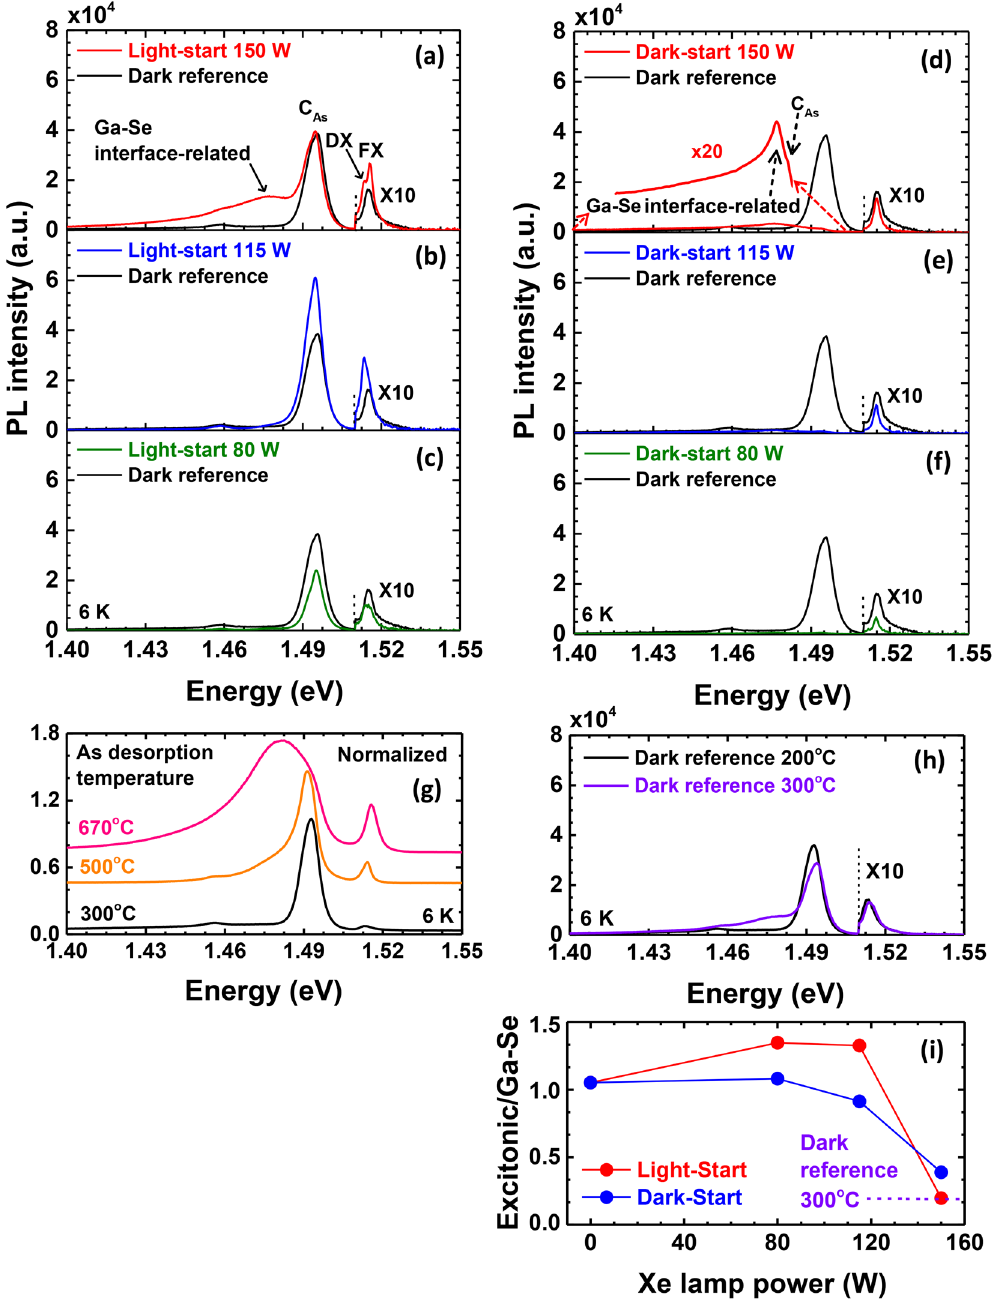
Figure 6. ( a – f ) PL emission from the ZnSe/GaAs interface and the GaAs epilayers of samples grown under light-start and dark-start conditions, respectively. From top to bottom, the Xe lamp power decreases from 150 W to 80 W. All spectra were compared with the dark reference sample. ( g ) Normalized PL spectra of the 200 °C-grown ZnSe samples corresponding to As desorption temperatures increasing from 300 °C to 670 °C. The peak corresponding to Ga-Se bonding increases with increasing As desorption. ( h ) PL emissions of dark reference samples grown at 200 °C and 300 °C. The spectrum of the samples grown under the higher Xe lamp powers mimic that of the 300 °C-grown dark reference sample. ( i ) The ratio of DX and FX excitonic emission intensity to the Ga-Se peak intensity at 1.48 eV for both sets of samples. The ratio for a dark reference sample grown at 300 °C is also